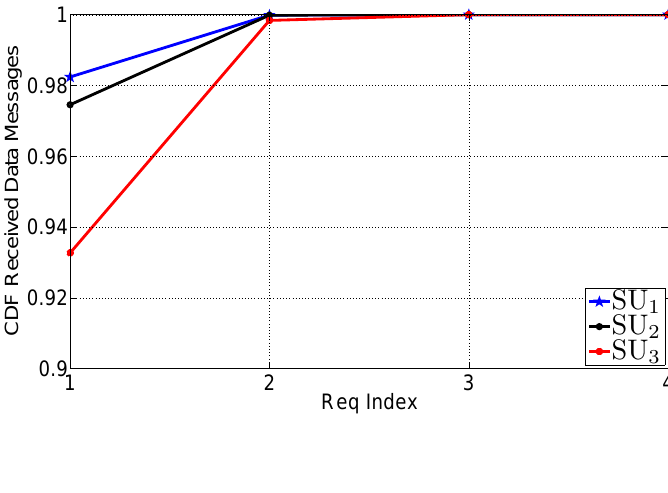
Figure 15. Cumulative Distribution Function (CDF) of received DATA messages before REQUEST messages in Scenario 1.